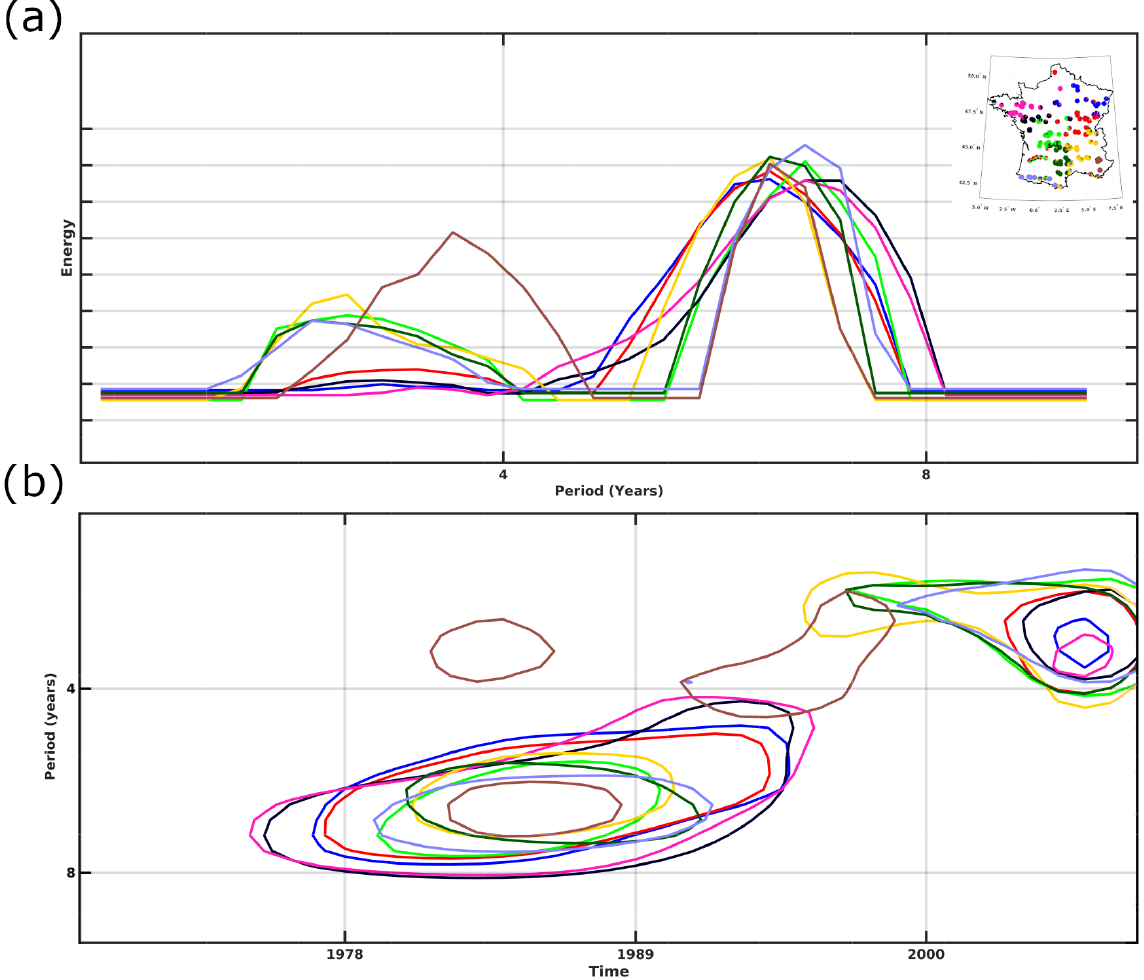
Figure 8. Interannual temperature time frequency variability in France. (a) Global wavelet spectra of homogeneous regions. (b) Wavelet spectra of homogeneous regions. For clarity, only timescales and time locations that are 95% statistically significant and with the largest variability are shown (colored